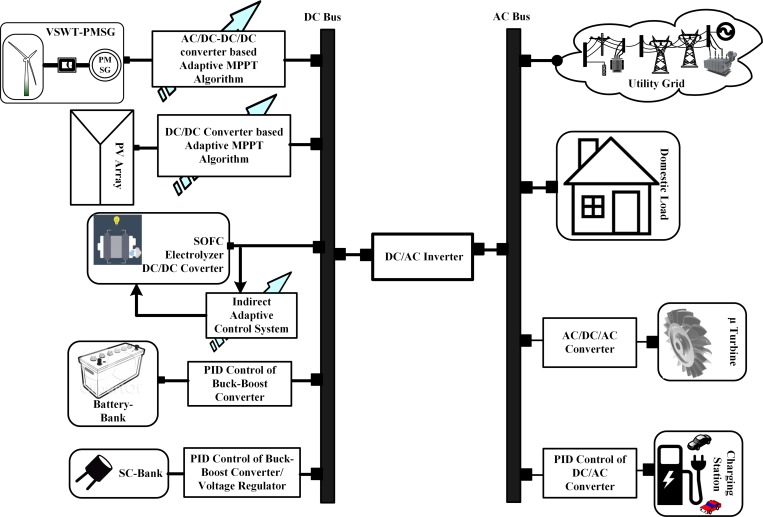
Hybrid power system.